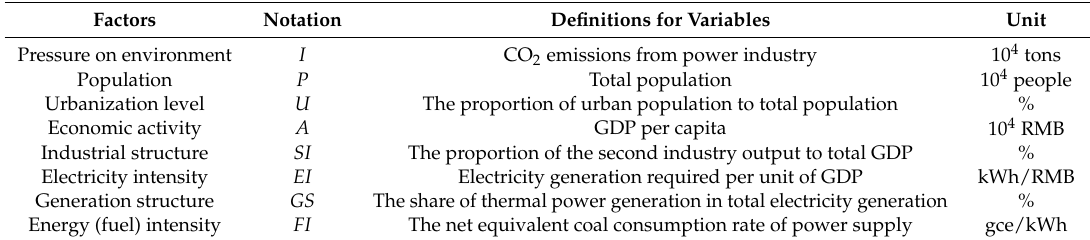
Table 1. The definitions for factors used in extended Stochastic Impacts by Regression on Population, Affluence and Technology (STIRPAT)